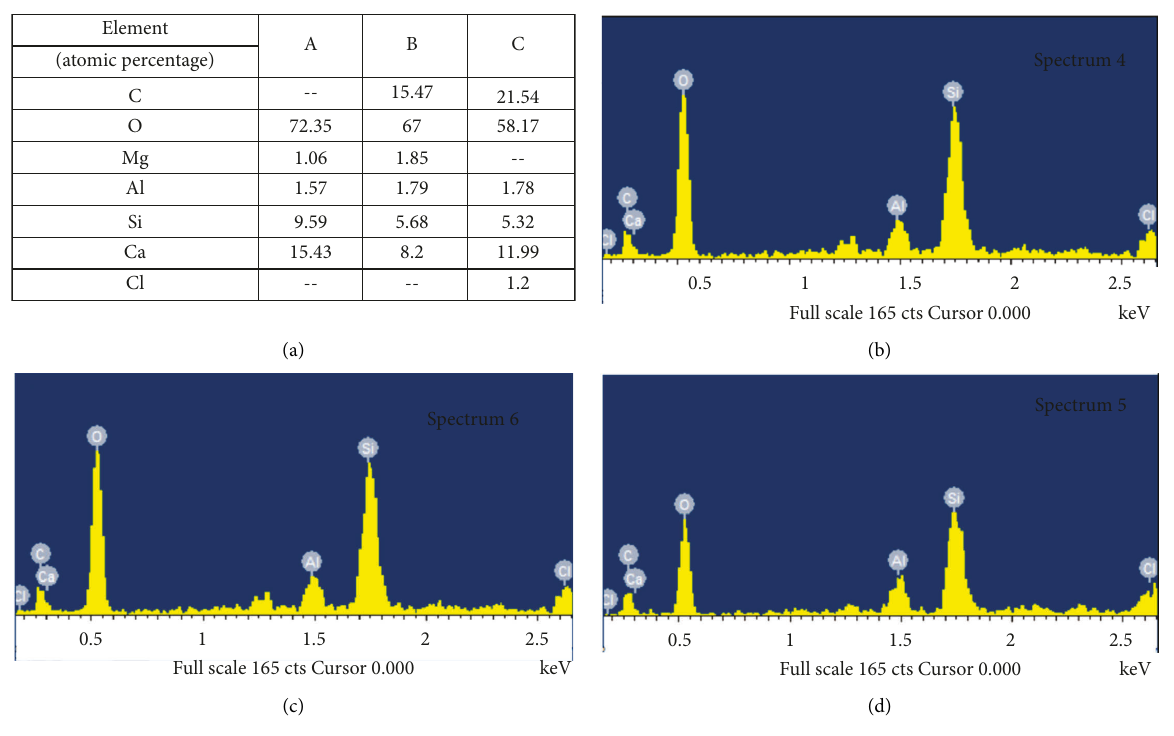
Figure 4: EDS analyses of bentonite-amended cement formed in (a) deionized water b; (b) bacterial suspension c; and (c) bacterial suspension and reaction solution (d); atomic percentage a.